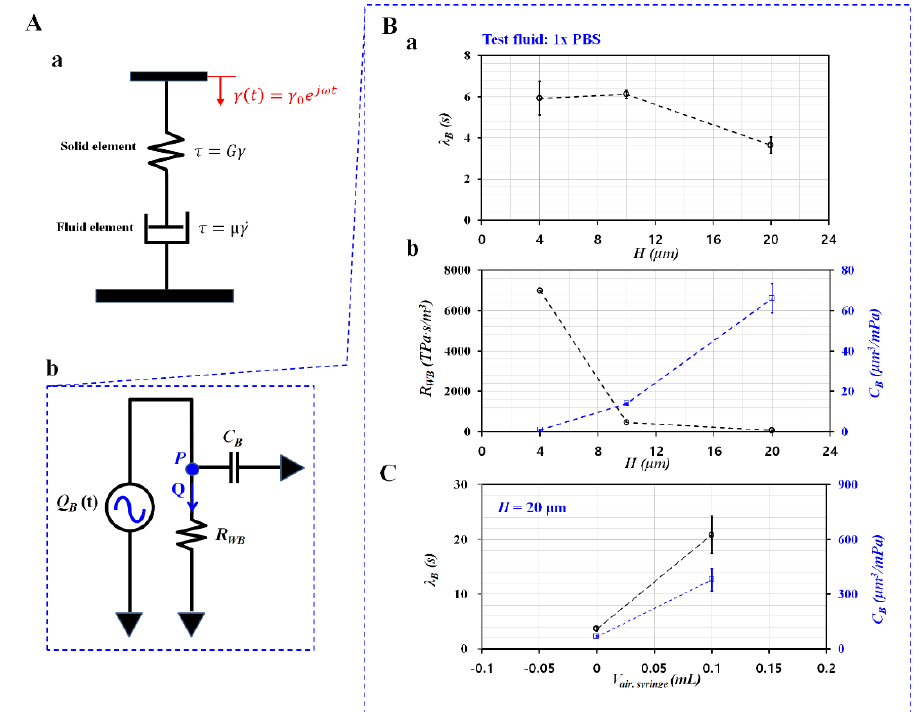
Figure 6. Mathematical representation and quantification of contributions of channel depth and air cavity to compliance. ( A ) Mathematical representation of conventional viscometer and microfluidic system. ( a ) Mathematical representation of conventional viscometer. ( b ) Mathematical representation of microfluidic system. ( B ) Evaluation of channel depth ( H ) on compliance. Here, 1x PBS as test fluid was infused into a microfluidic system. ( a ) Variations of λ B with respect to H . ( b ) Variations of R WB and C B with respect to H . ( C ) Evaluation of air cavity on compliance.